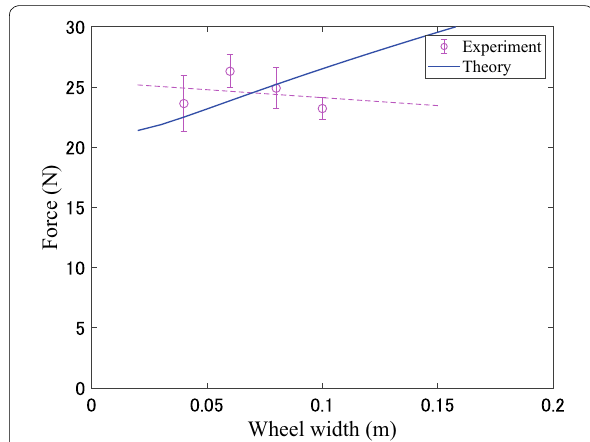
SD resistance force of steady-state sinkage at Fig. 16 Mean ± different wheel width. Diameter 0.17 m; mass 2.5 kg